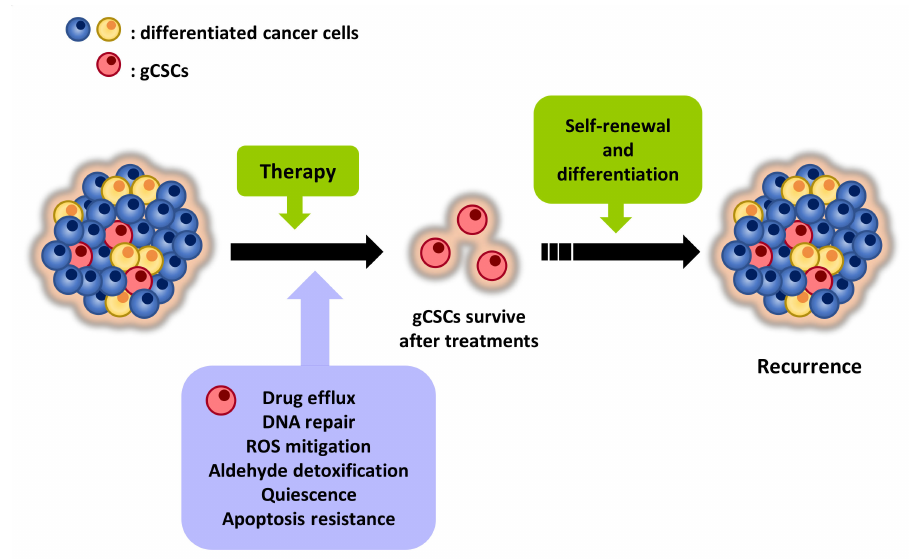
Figure 1. gCSCs are responsible for therapy failure and relapse. gCSCs represent a minority subpop- ulation of cancer cells within the tumor bulk that are characterized by unique properties that make them resistant to conventional therapies. As a consequence, they promote tumor recurrence and, with it, dismal